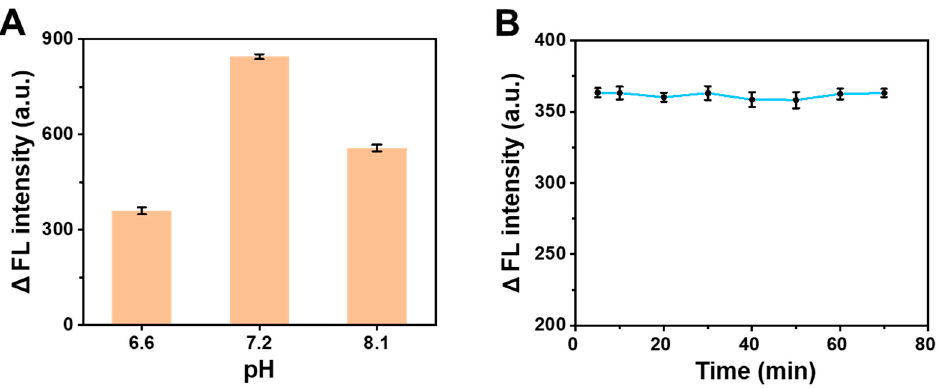
Figure 2. ( A ) Optimization of pH on the change in fluorescence intensity of the AA-BSA system. ( B ) Optimization of reaction time on the change in fluorescence intensity of the AA-BSA system.